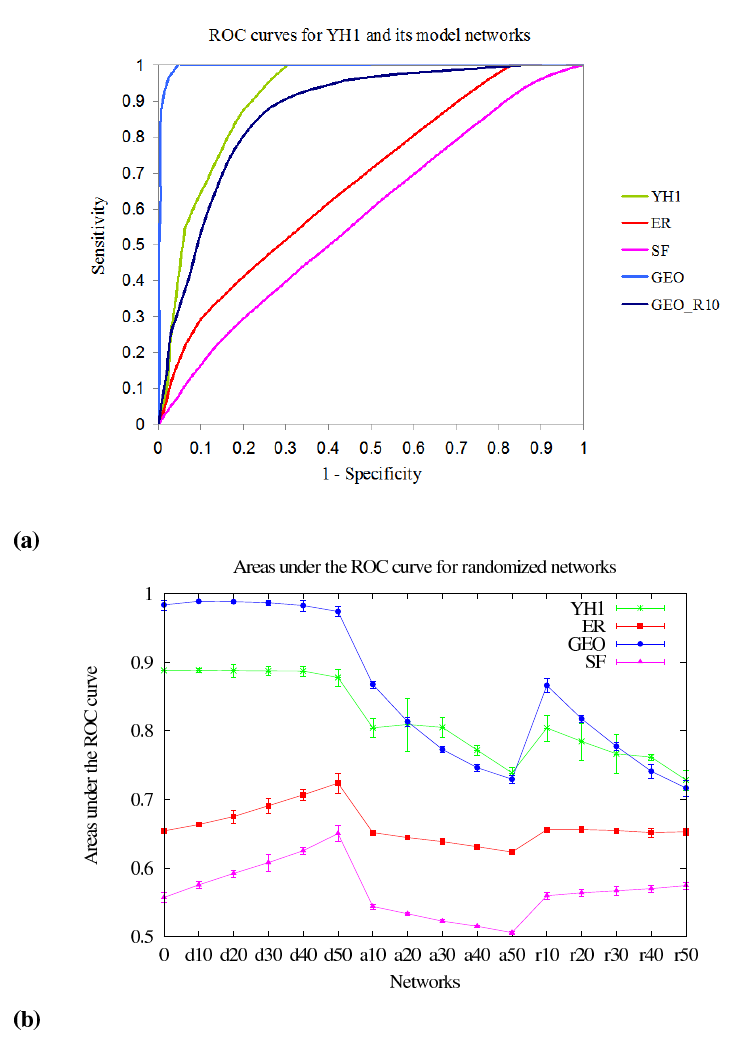
Figure S4: (a) ROC curves illustrating the performance of the embedding algorithm for YH1 PPI network and one network belonging to each of the following model networks that are of the same size as YH1: ER, SF, GEO, and randomized GEO network (“GEO R10”) obtained by randomly rewiring 10% of edges. (b) Areas under the ROC curve (AUCs) for YH1 and its ER, GEO, and SF model networks (denoted by “0” on x-axis), as well as for their randomized versions obtained by randomly deleting, adding, and rewiring (denoted by “d”, “a”, and “r” on x-axis, respectively) 10%, 20%, 30%, 40%, and 50% of their edges (denoted by “10”, “20”, “30”, “40”, and “50” on x- axis, respectively). For each of the network models and each of the randomization schemes, points in the panel represent averages of AUCs over 10 networks. The error bar around a point is one standard deviation below and above the